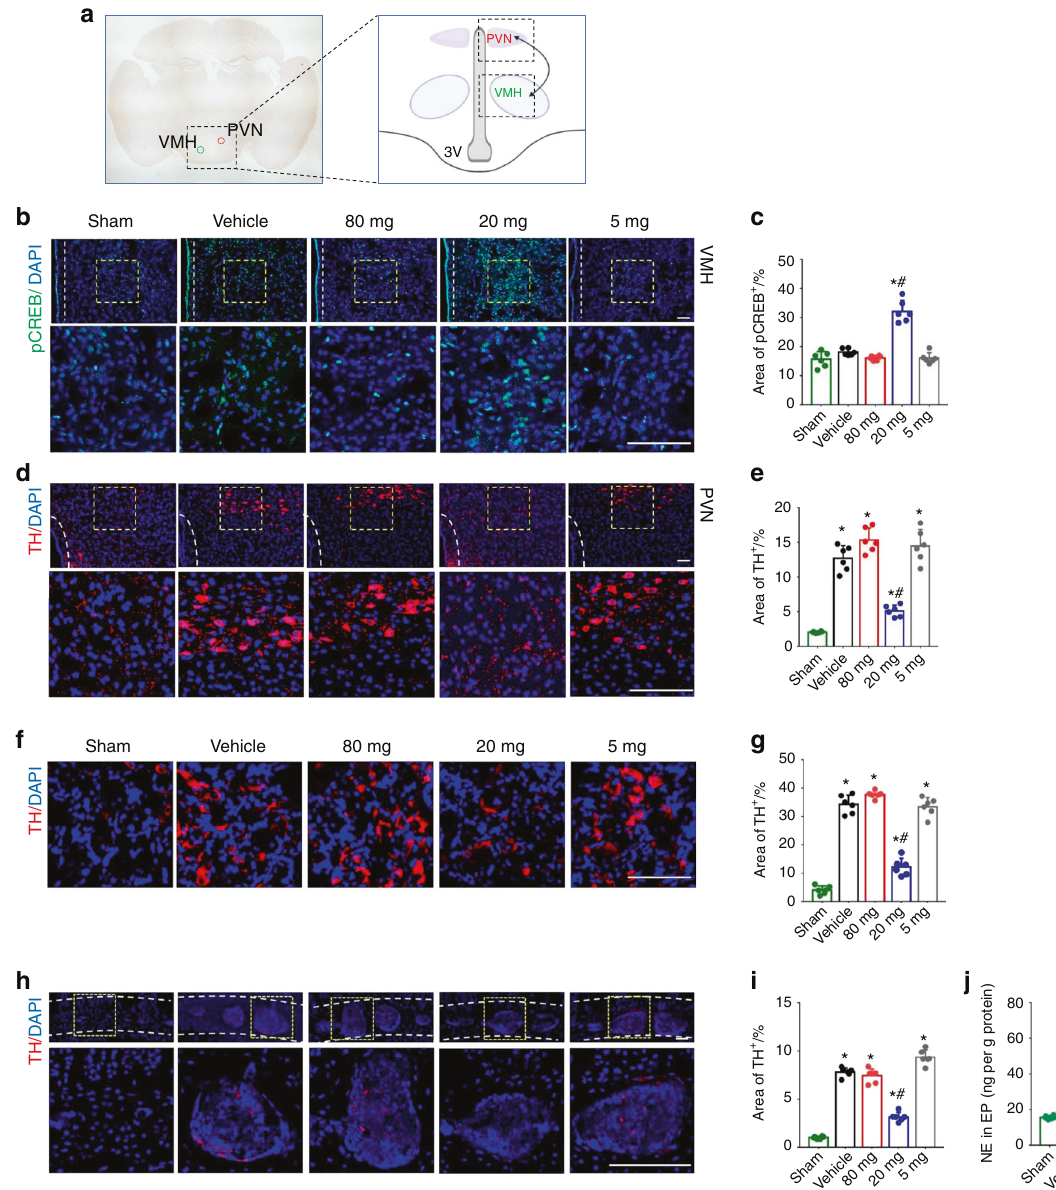
Fig. 4 Low-dose celecoxib reduced endplate porosity by decreasing sympathetic activity through hypothalamic CREB signaling. a Location of the ventromedial hypothalamic nucleus (VMH) and the paraventricular nucleus (PVN) in the hypothalamus. b Representative images of immunostaining of pCREB (green) and DAPI (blue) in the VMH at 2 weeks after celecoxib or vehicle treatment. c Quantitative analysis of the percentage of pCREB + area in the VMH. d Representative images of immunostaining of TH (red) and DAPI (blue) in the hypothalamic PVN at 2 weeks after celecoxib or vehicle treatment. e Quantitative analysis of the percentage of TH + area in the PVN. f Representative images of immunostaining of TH (red) and DAPI (blue) in the cervicothoracic ganglion at 2 weeks after celecoxib or vehicle treatment. g Quantitative analysis of the percentage of TH + area in the cervicothoracic ganglion. h Representative images of immunostaining of TH (red) and DAPI (blue) in the endplates at 2 weeks after celecoxib or vehicle treatment. i Quantitative analysis of the percentage of TH + area in endplates. J ELISAs of norepinephrine concentration in lumbar endplates at 2 weeks after celecoxib or vehicle treatment. Scale bars, 50 μ m ( b, d, f, h ). * P < 0.05 compared with the sham group and # P < 0.05 com p ared with the vehicle group at the corresponding time points. n = 6 per group ( c, e, g, i, j